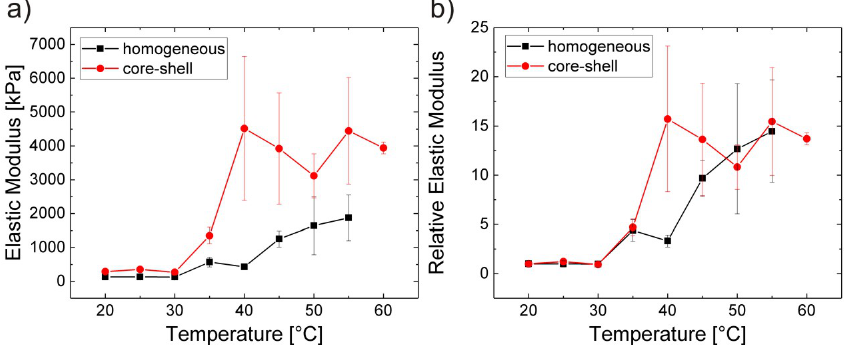
Figure 6. Elastic moduli of core-shell and homogeneous microgels depending on temperature: ( a ) absolute values and ( b ) normalised with respect to the elastic modulus at 20 ◦ C. Taken from